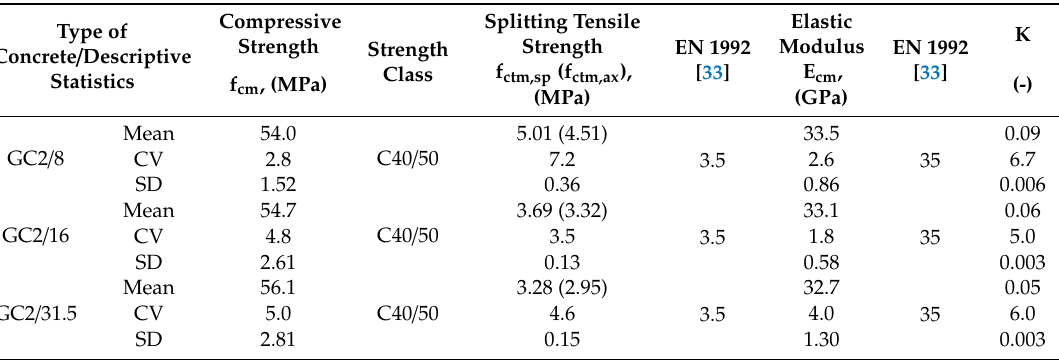
Table 6. Mechanical properties of the